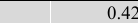
Numerical values of linguistic terms.